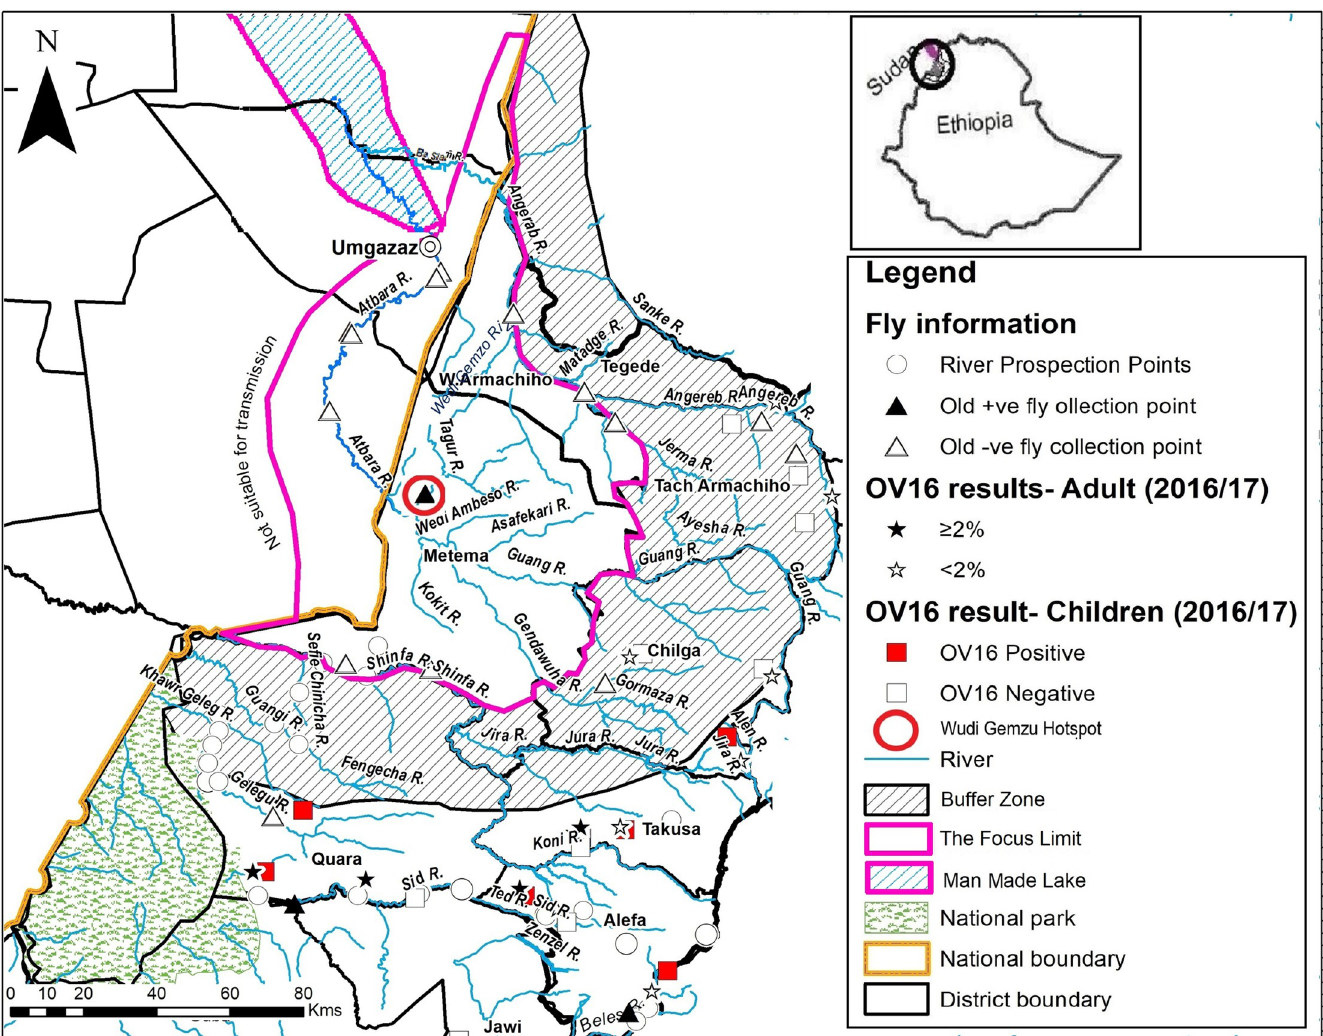
Fig 5. Delineated Map of Galabat- Metema Focus showing the Buffer Zone, the Hotspot, and the Transmission zone where MDA was halted] Not copyrighted, and was created in ArcGIS.